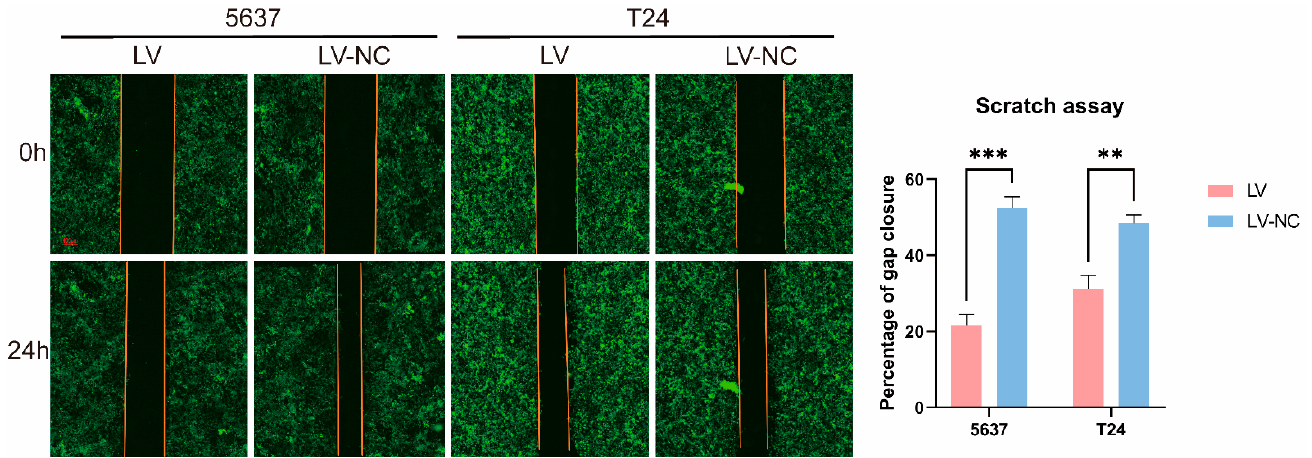
Figure 5. The scrape motility assay of two groups in 5637 and T24 cell lines (transfection group, LV; negative control group, LV-NC). ** indicates p -value < 0.01. *** indicates p -value < 0.001.